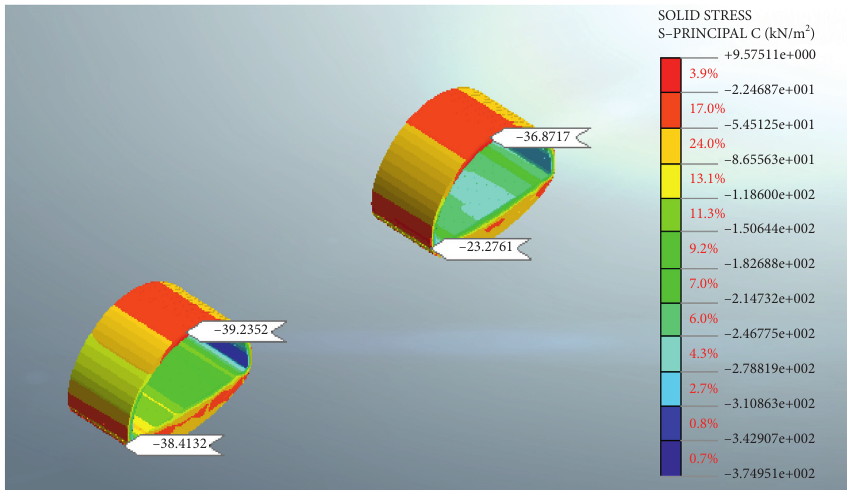
Figure 30: Three-step method of second lining stress